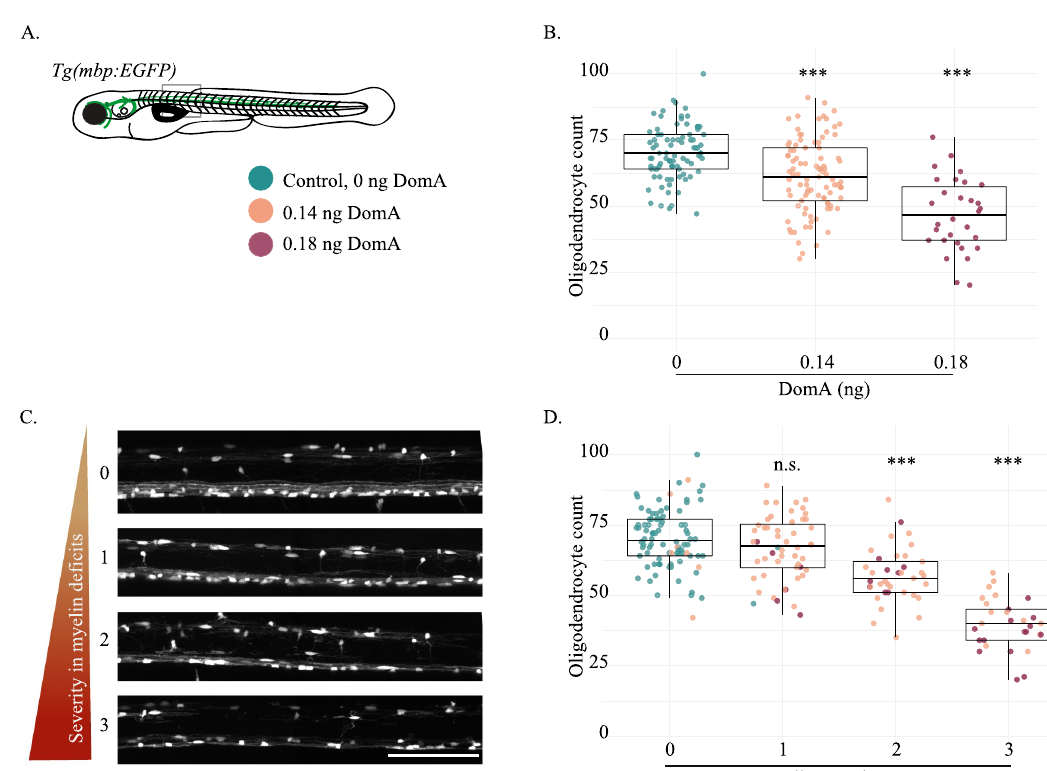
Figure 2. Exposure to DomA at 2 dpf reduces the number of myelinating oligodendrocytes in fish with severe myelin defects in a dose dependent manner. ( A ) The Tg(mbp:EGFP) transgenic line was used to quantify myelinating oligodendrocytes at 4 dpf. The rectangle delineates the approximate location within the spinal cord where the image was acquired (somites 6–10). ( B ) Number of myelinating oligodendrocytes quantified at 4 dpf in the spinal cords of fish exposed to different doses of DomA at 2 dpf. Each point represents the number of myelinating oligodendrocytes within the 403.9 μM imaging area in a single fish. (Control 0 ng – median = 70 and IQR = 13; DomA 0.14 ng – median = 62, IQR = 20; DomA 0.18 ng – median = 47, IQR = 20). ( C ) Representative images of laterally mounted Tg(mbp:EGFP) fish classified by myelin severity, ranging from 0, representing control-like myelin sheaths, to 3, representing the most severe myelin phenotype observed. ( D ) Fish used in ( B ) were further subdivided by the severity of the myelin defect observed. The myelinating oligodendrocyte counts were then plotted by the myelin severity score. Scale bar = 100 μm, n.s. = not significant, *** p < 1 e−3 using a generalized mixed effects model with a negative binomial